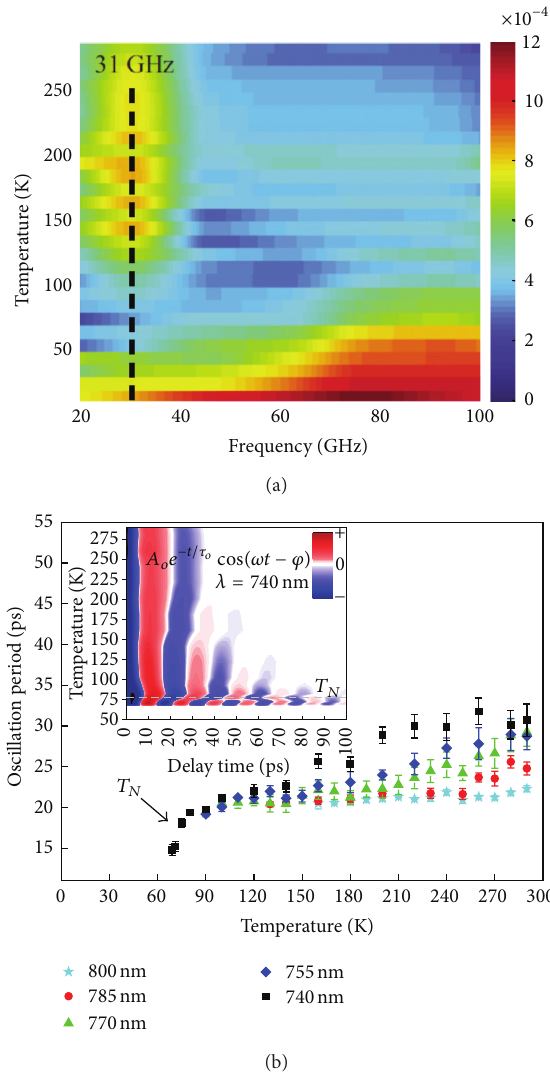
Figure 10: (a) Temperature dependence dephasing time of the oscillation component in Δ𝑅/𝑅 at various wavelengths of HoMnO 3 . Inset: the normalized dephasing time as a function of tempera- tures at various wavelengths [38]. Figures were reproduced with permission from Shih et al. [38]. (b) Temperature dependence of dephasing times: red squares for acoustic phonons, black circles for optical phonons, and blue triangles for electronic relaxation time [37]. Figures were reproduced with permission from Jang et al. [37].